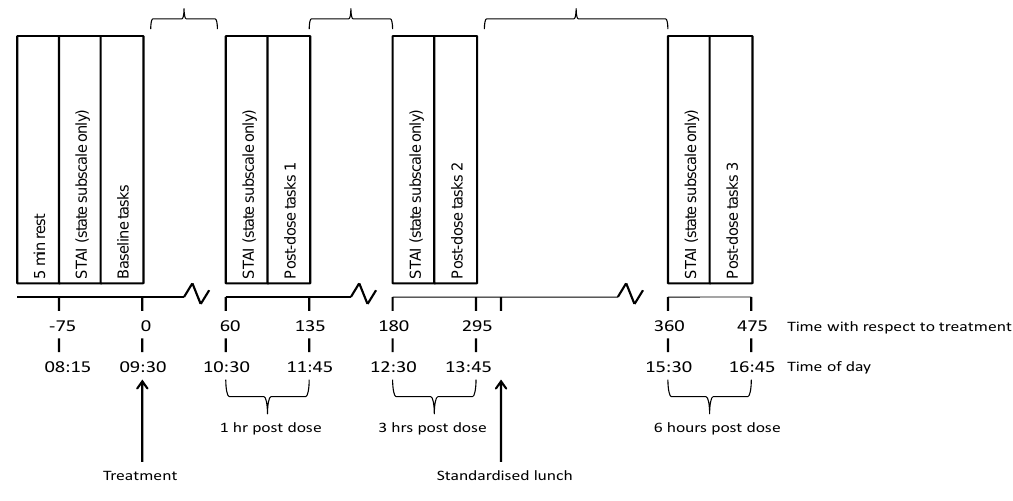
Figure 1. Testing session timeline for all visits. Participants were informed to arrive at the lab no later than 8:00am where continued compliance with the study inclusion criteria was confirmed and breakfast consumption reported before a short rest. Participants were then taken to the testing suite and completed the state subscale of the Figure 4. Testing session timeline for all visits. Figure 4. Testing session timeline for all State Trait Anxiety Inventory (STAI) before completing the 75 min baseline battery of cognitive tasks. Immediately after completion participants consumed their capsule of treatment,attheirdesk,withaglassofmilk.Anhoursbreakfollowedthis;whereparticipantswereinformedtoremainintheresearchcentrenotconsuminganythingapart from water, sleeping or exercising, after which participants returned to the testing suite to complete the first post dose repetition of the STAI state subscale and cognitive tasks. A further 45 min breakfollowed thisafter which thesecond post doserepetition of STAI andcognitive taskswascompleted.Participants then immediately consumed the standardized lunch at their desks and this was included within the 1hr 45min break which ensued. Finally, participants completed the third and final repetition of post doseSTAIandcognitivetasksafterwhichtheywerepermittedtoleavethelab.